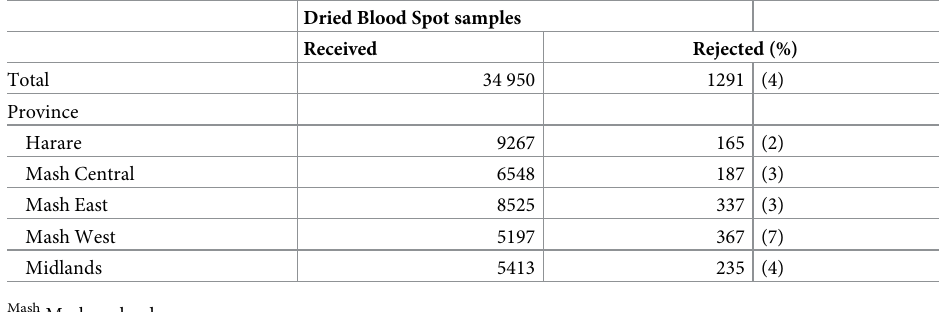
Table 4. Proportion of rejected DBS samples at NMRL and Provinces, January—December